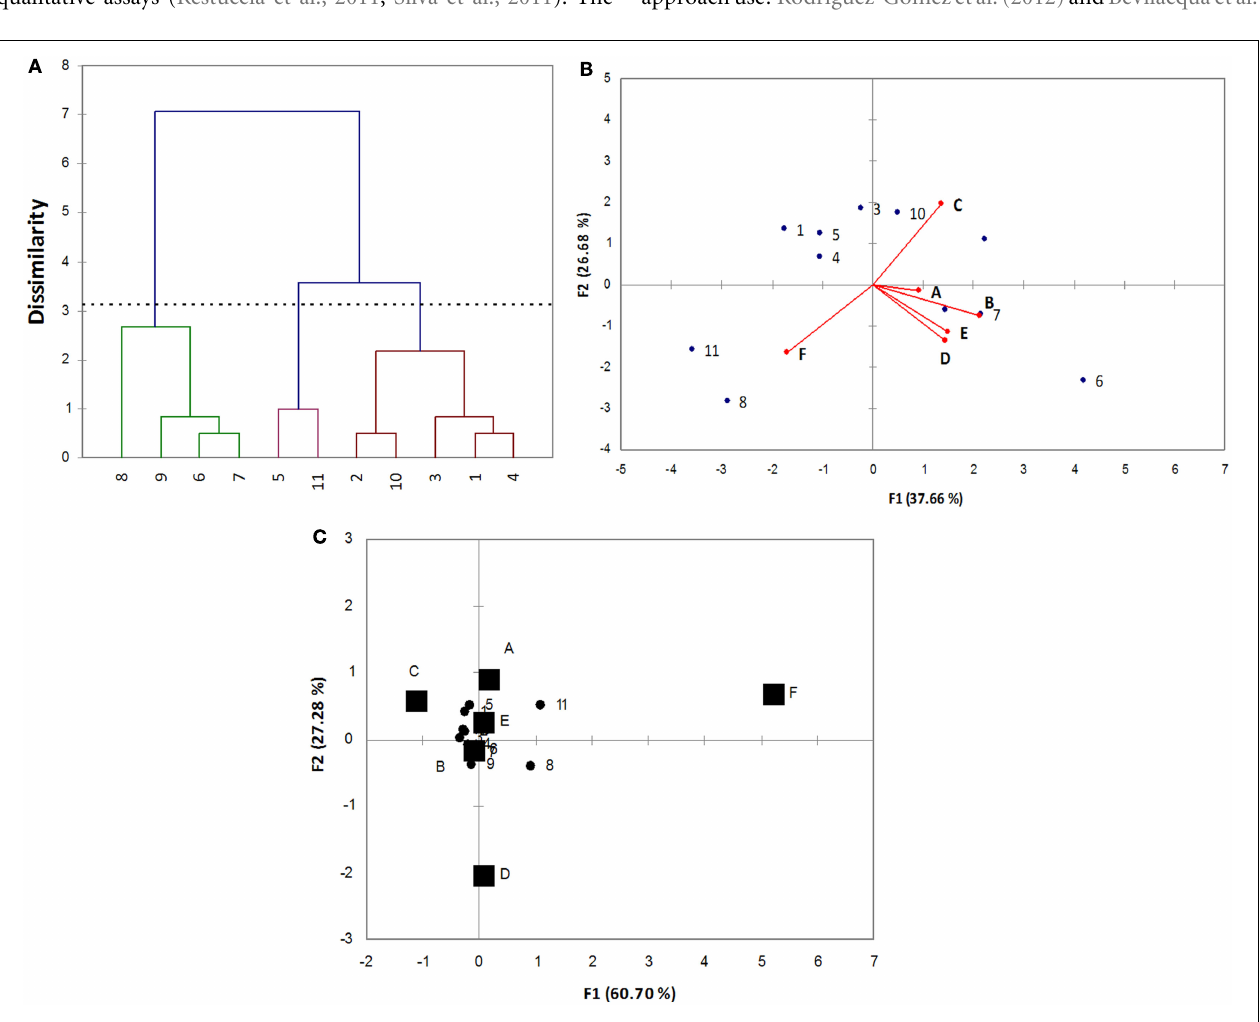
FIGURE 2 | Multivariate analyses for the data reported inTable 3. (A) Cluster analysis; (B) principal component analysis; (C) correspondence